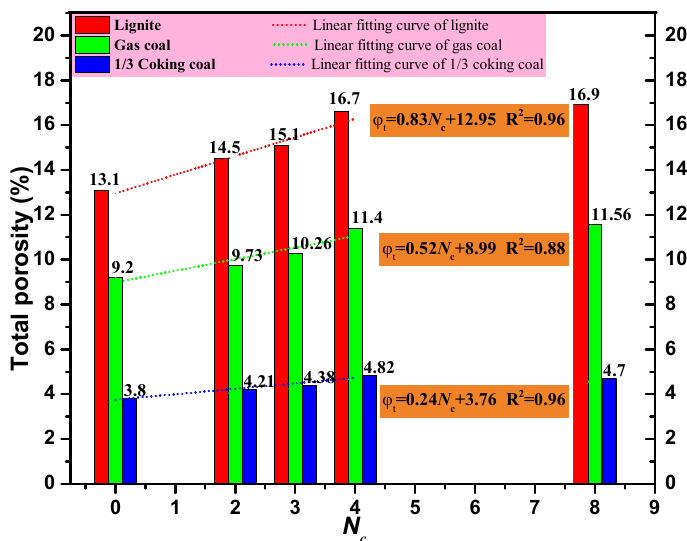
11 of 19 Table 2. Parameters of fitting functions between the total porosity and cycle numbers for three coal cores.